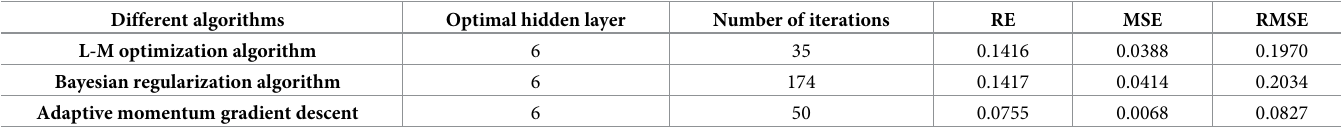
Table 2. Training results of different algorithms. Different